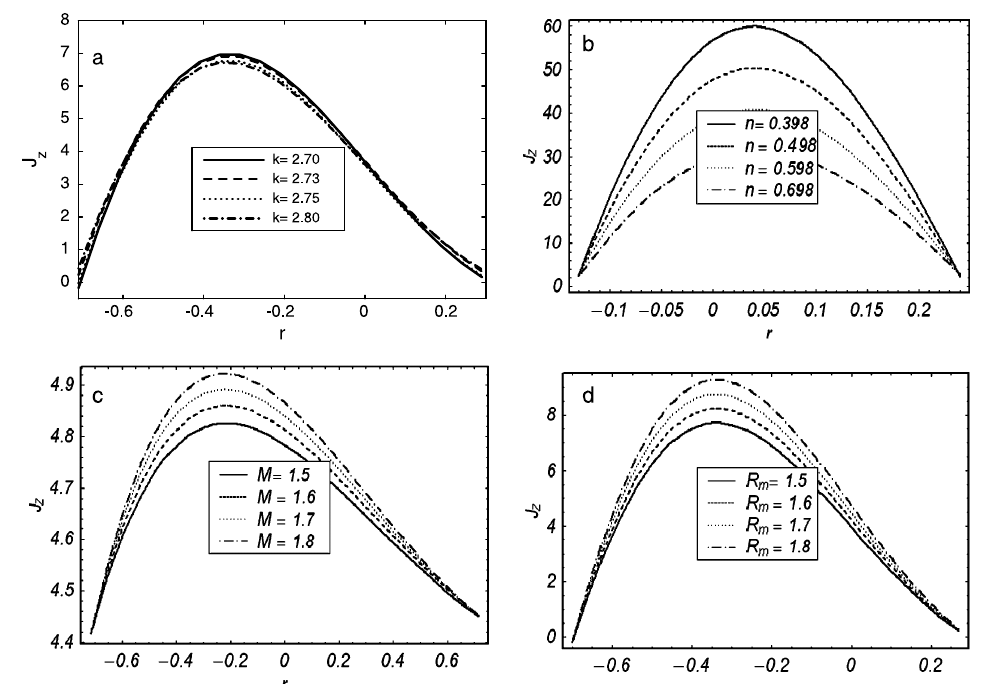
Fig. 6. (a) Current density versus J z versus r for θ = 0 . 5, α = 0 . 3, R m = 1 . 5 ,E = − 1 ,x = − 0 . 2 ,n = 0 . 9 ,M = 3 . 3 and We = 0 . 9. (b) Current density J z versus r for α = 0 . 3, θ = 0 . 5, R m = 1 . 5 ,E = − 1 ,x = − 0 . 2 ,k = 2 . 5 ,M = 6 . 23 and We = 0 . 6. (c) Current density J z versus r for α = 0 . 3 ,θ = 0 . 5 , R m = 2 ,E = − 1 ,x = − 0 . 2 ,k = 2 . 5 ,n = 0 . 9 and We = 0 . 9. (d) Current density J z versus r for α = 0 . 3 ,θ = 0 . 5, M = 3 . 3 ,E = − 1 ,x = − 0 . 2 ,k = 2 . 5 ,n = 0 . 9 and We = 0 .